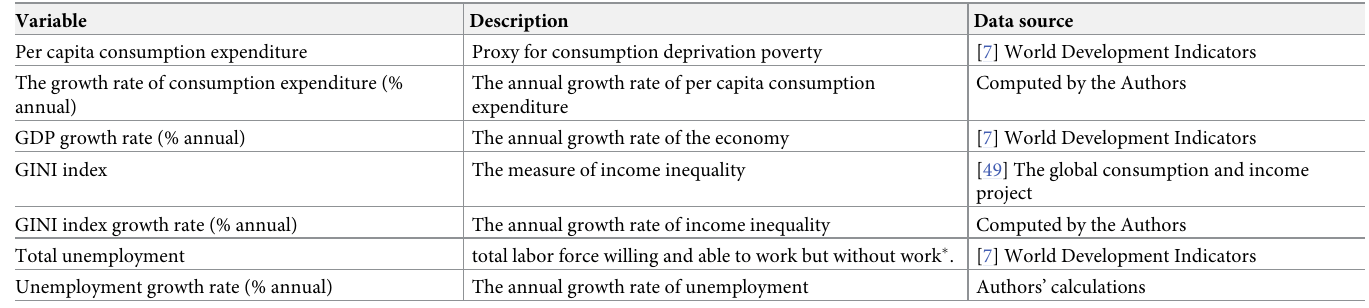
Table 1. Description of variables and corresponding statistical data sources.